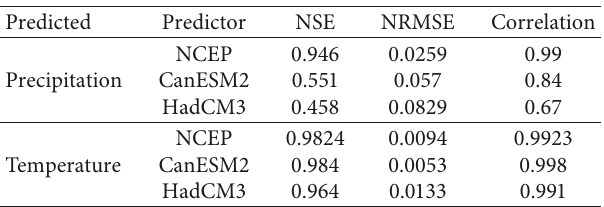
Table 6: The results of Mann-Kendall test for historical and modeled data under RCP